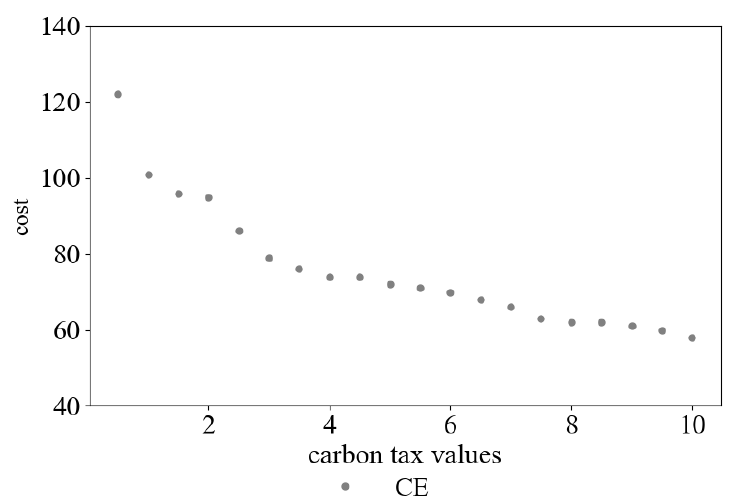
Figure 2. The change in CE under different carbon tax values.